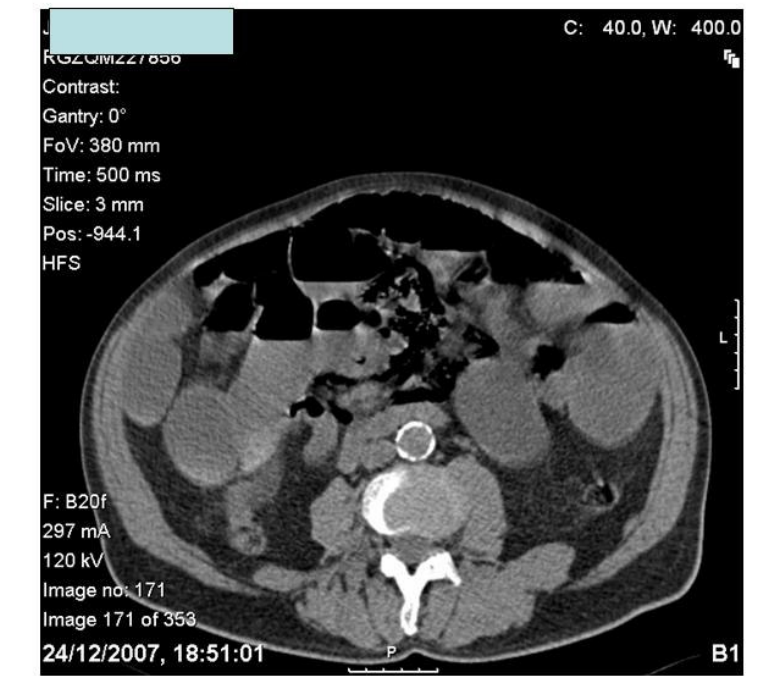
FIGURE 1. Barium enema showing severe diverticular disease of the sigmoid